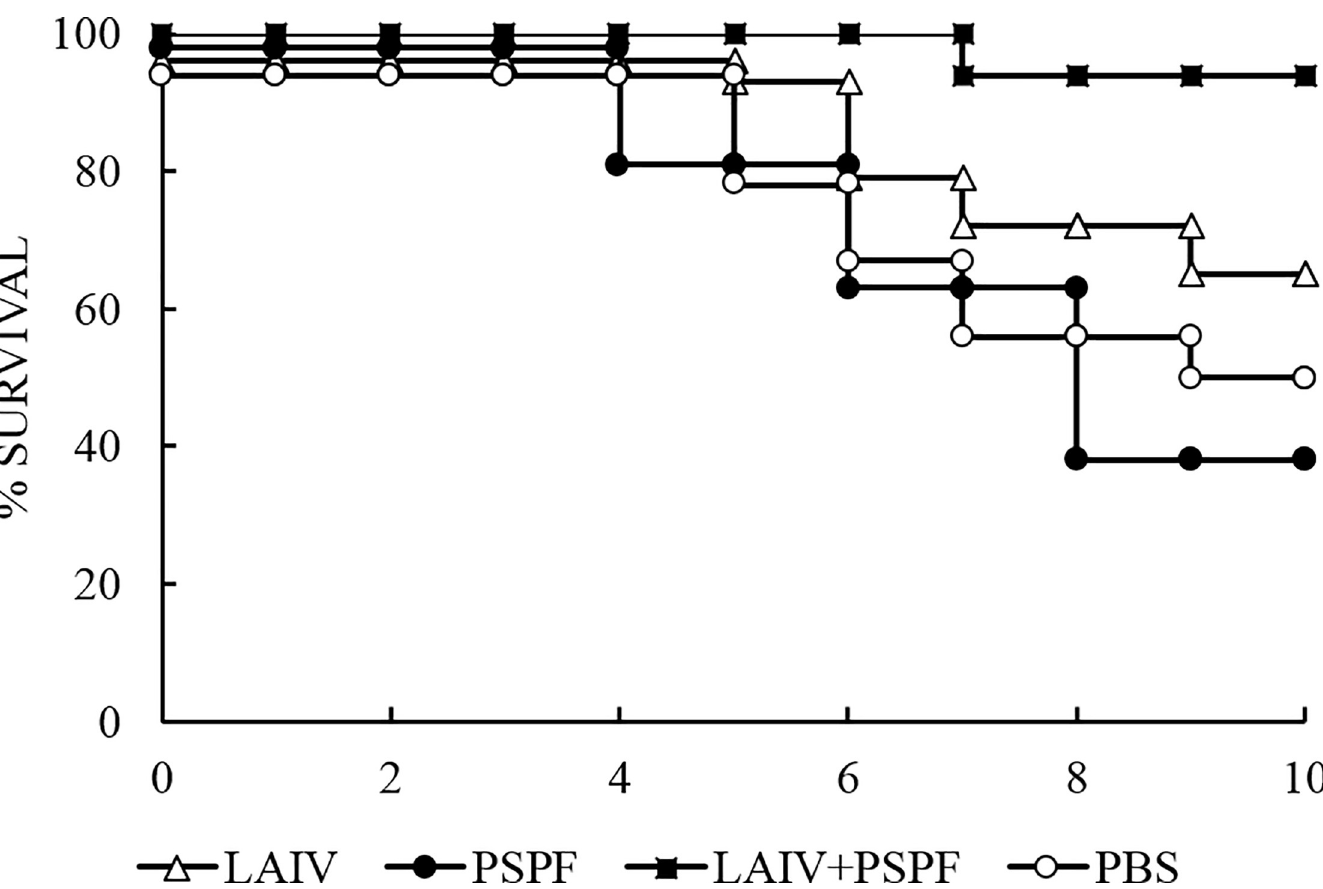
Fig 6. Vaccination protects mice from S . pneumoniae infection, complicated by secondary influenza infection. Mice (n = 14 per group) were infected with sublethal dose of S . pneumoniae strain 73 (type 3), then challenged 24 hours later with a sublethal dose of influenza virus H1N1. The survival of mice was recorded daily for 10